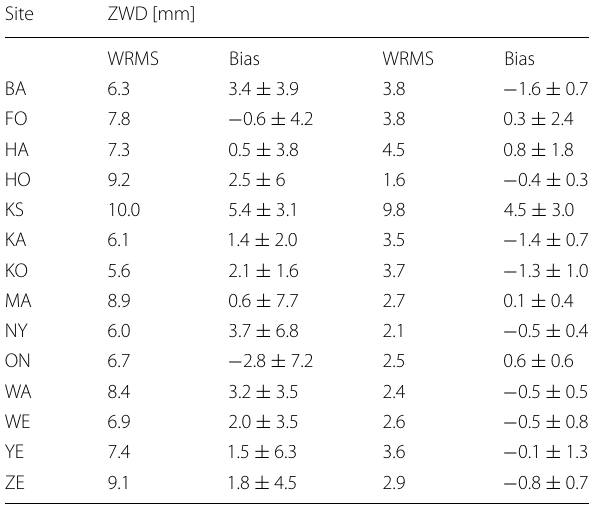
Fig. 10. Evaluated at 6000 km, COL reduces the baseline repeatability by 35% from 6.5 to 4.2 mm. Further elabora- tion will follow in “Discussion” section.